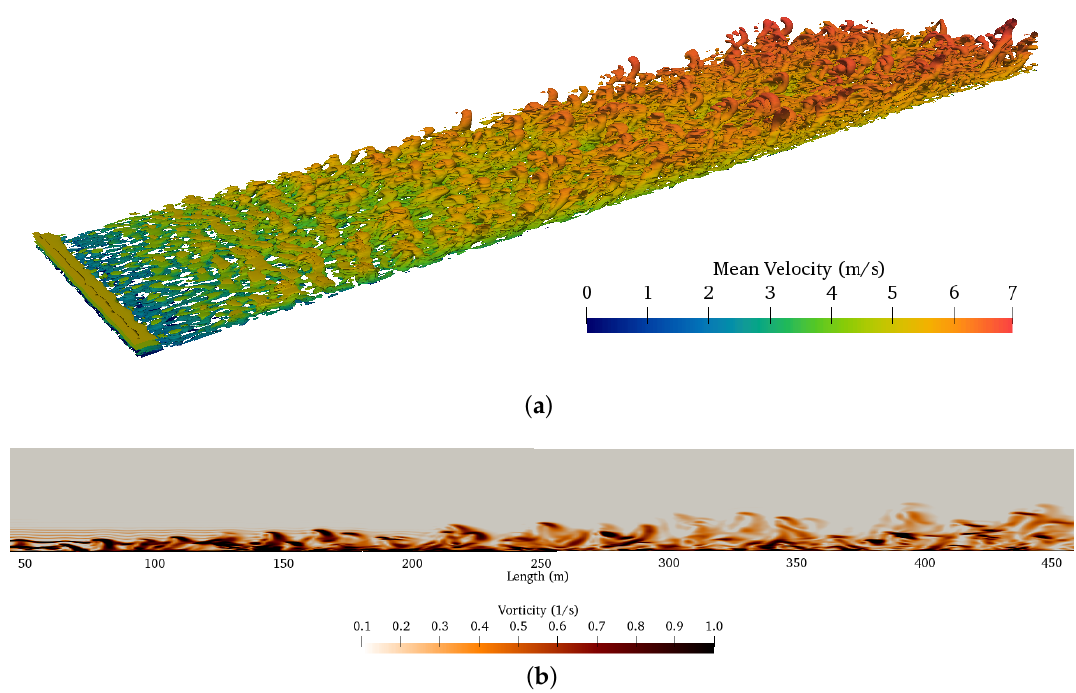
Figure 11. View on the instantaneous flowfield after 400 s of simulation. ( a ) shows the iso-contours for Q = 0.01 s − 2 , which is the 2nd invariant of the velocity gradient tensor. Surface coloring is carried out in accordance with mean velocity, as shown in the color bar. ( b ) shows the vorticity of the flowfield after 400 s on a section on the XZ-plane at y = 0, with a height up to z = 40